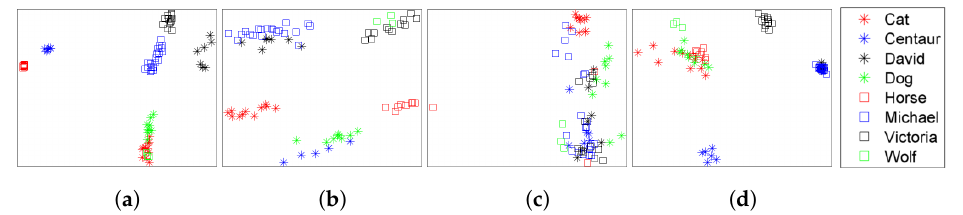
Figure 11. 2D PCA projection of shape descriptors computed by: ( a ) original Shape-DNA; ( b ) cShape-DNA; ( c ) GPS; and ( d ) LESI algorithms from down sampled TOSCA dataset by rate of 20%.